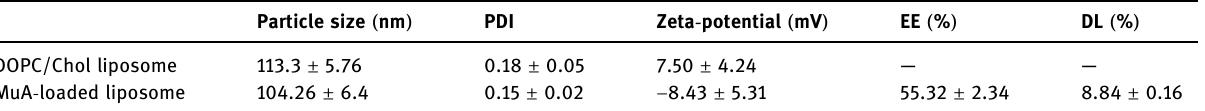
Table 2: The measured physical properties of DOPC/Chol liposomes and MuA - loaded liposomes ( n = 3 ) in PBS ( pH 7.4, 0.01 M